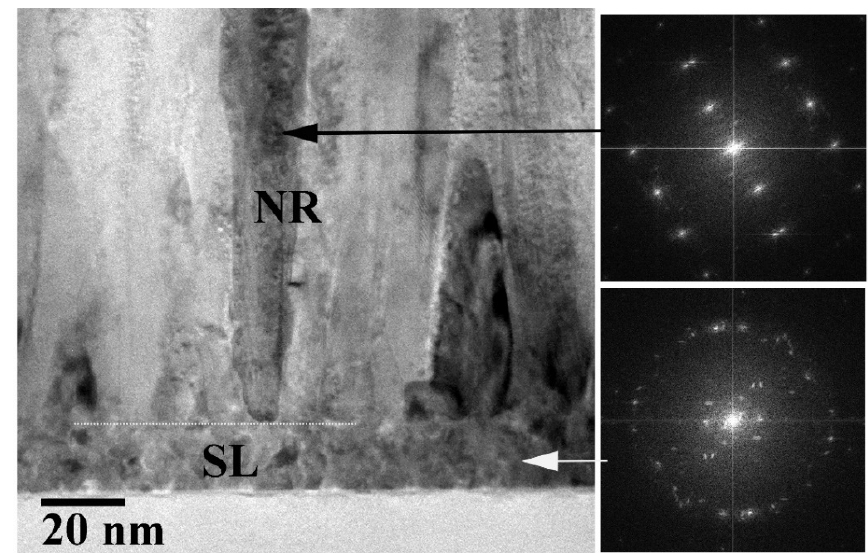
Figure 1. Cross-sectional high-resolution TEM image of the ZnO NRs grown on an SL (PH at 100 °C, no PT). Electron diffraction patterns are also shown from the selected areas of NRs ( top-right ) and the SL ( bottom-right ).